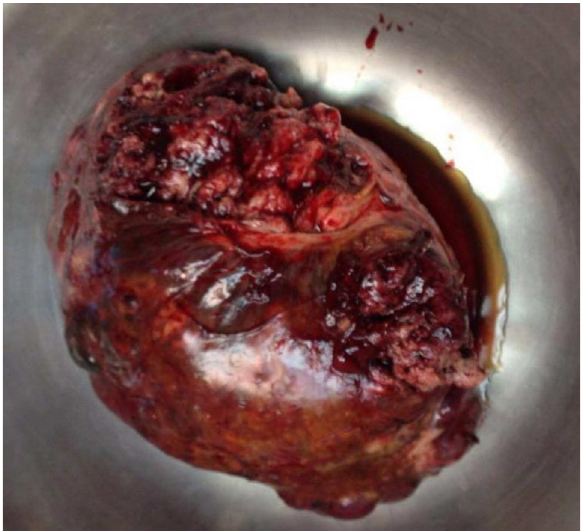
Figure 2: GIST exhibits a solid, sometimes cystic fleshy tumor with multiple hemorrhagic foci.